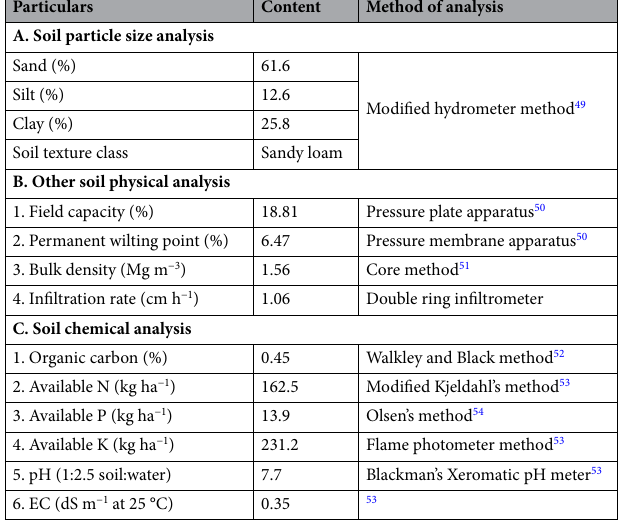
Table 4. Physical and chemical properties of soil of the experimental field.